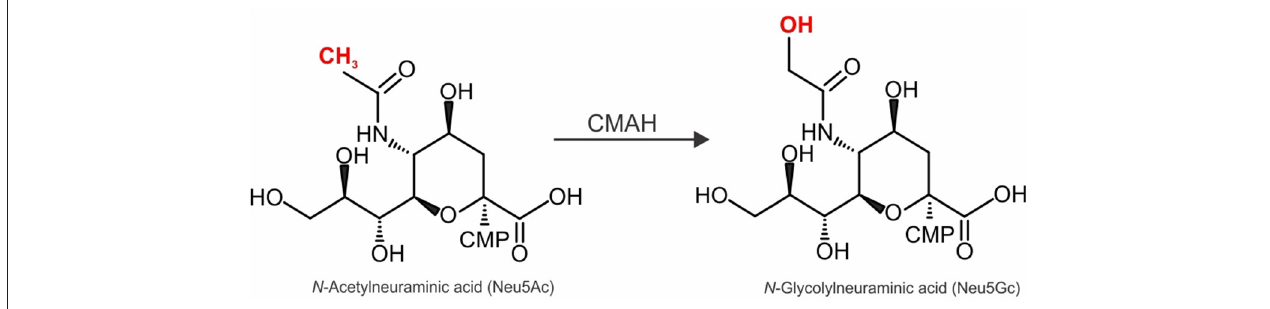
FIGURE 1 | Enzymatic activity of CMAH and its effect on complex N -linked glycan structure. Schematic representation of the conversion of sialic acid cytidine monophospho- N -acetylneuraminic acid (CMP-Neu5Ac) to cytidine monophospho- N -glycolylneuraminic acid (CMP-Neu5Gc) catalyzed by the CMP-Neu5Ac hydroxylase